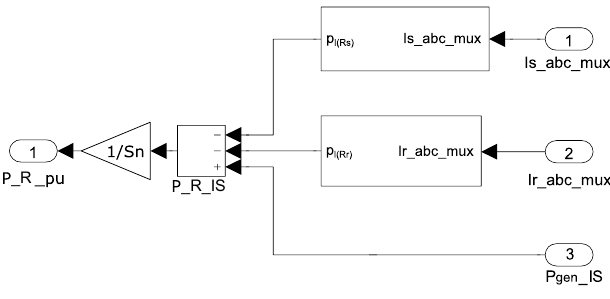
Figure 6. Rotor and stator power losses